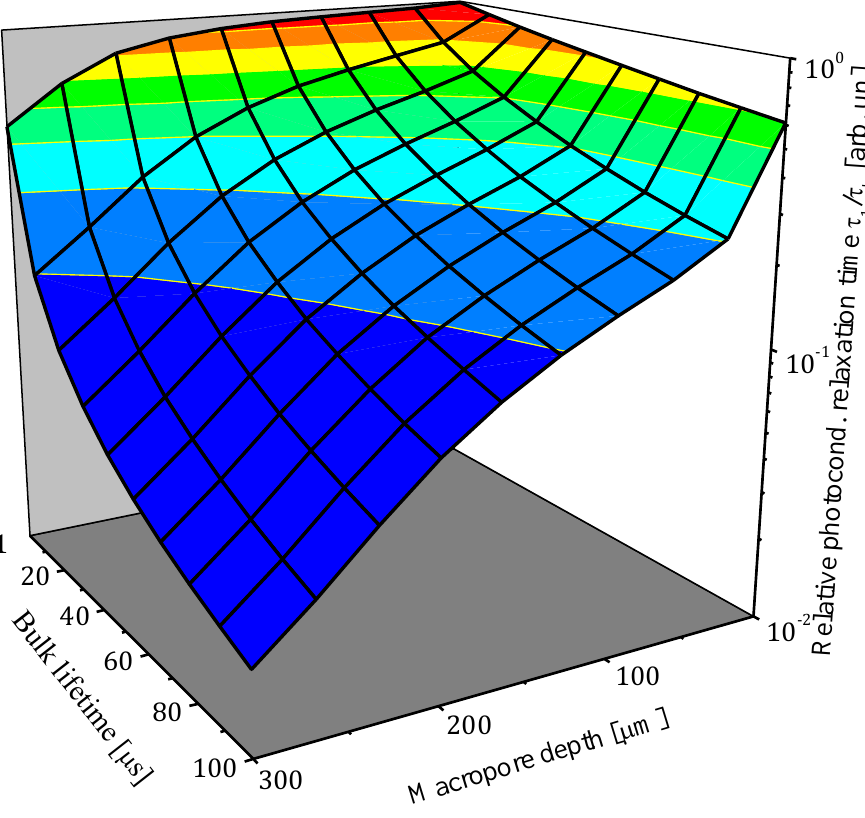
Figure 7. The dependence of the relative relaxation time of photoconductivity on the depth of the macropores and the bulk lifetime at thickness of macroporous silicon is 300 μm.